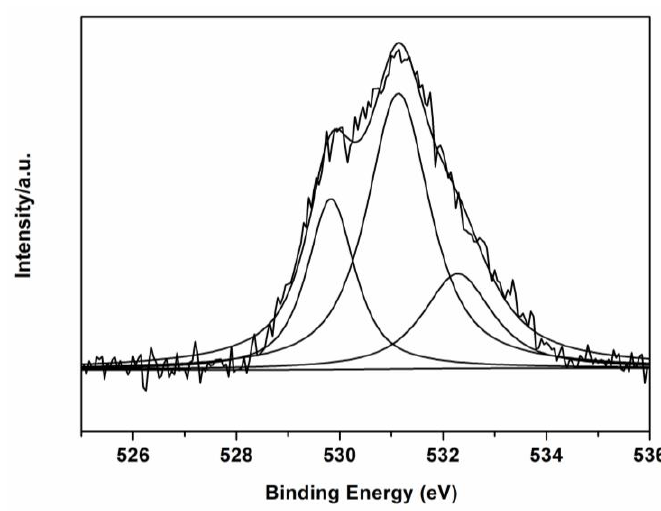
Figure 6. XPS spectrum of the O 1s region for the catalyst. Table 2. Peak-fitting results of W 4f XPS spectra of the catalyst.